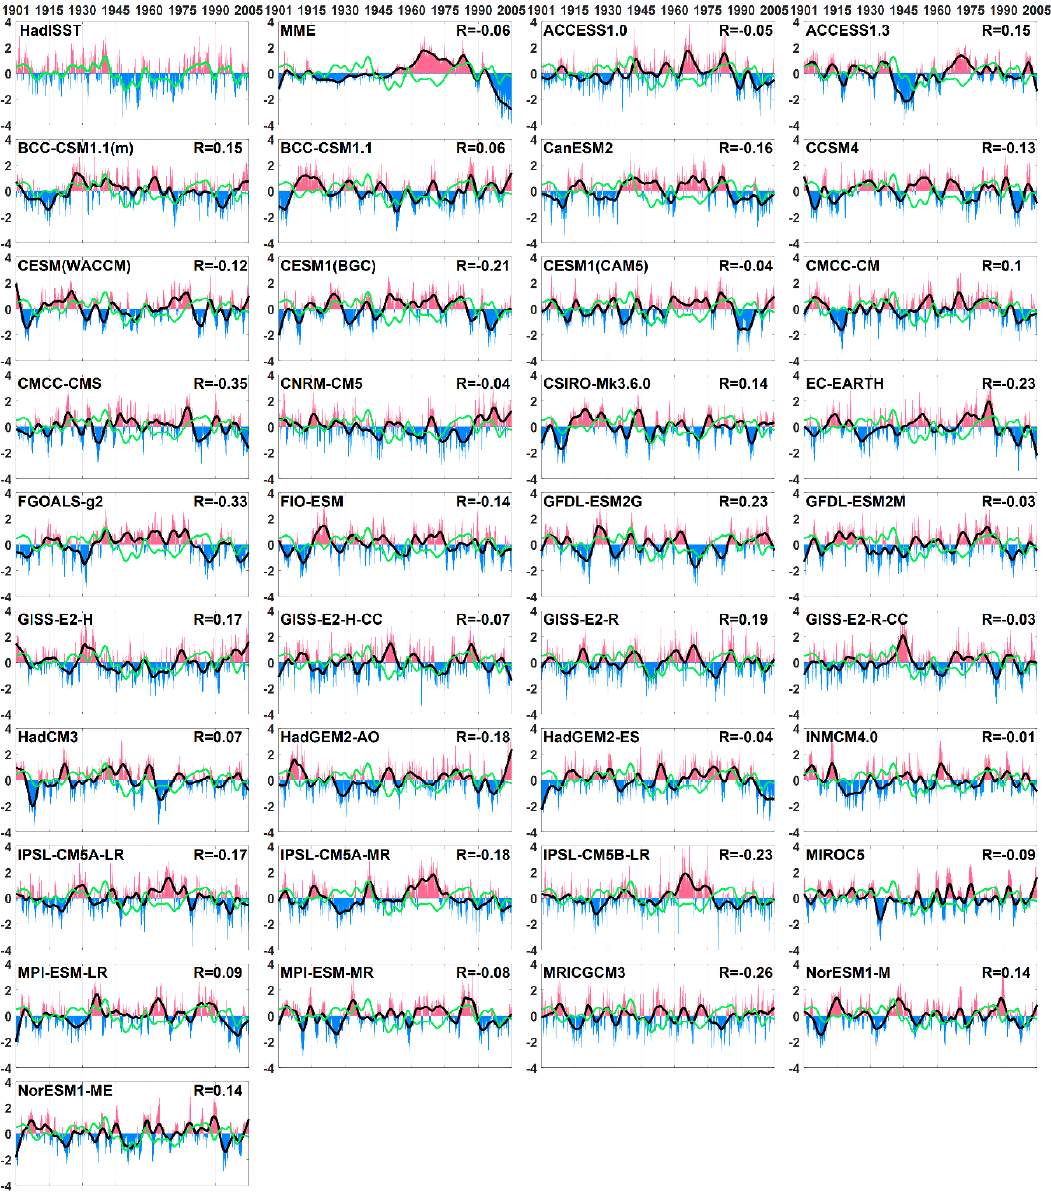
Figure 3. PC1 time series in the observations and 35 model SSTAs, including those from the MME, for the period 1901–2005. The green line indicates a 6-year moving-average filter in the observation PC1 time series; the black line indicates a 6-year moving-average filter in the model PC1 time series; red shading indicates the positive phase; blue shading indicates the negative phase; and R represents the correlation coefficients of the simulation and observation.